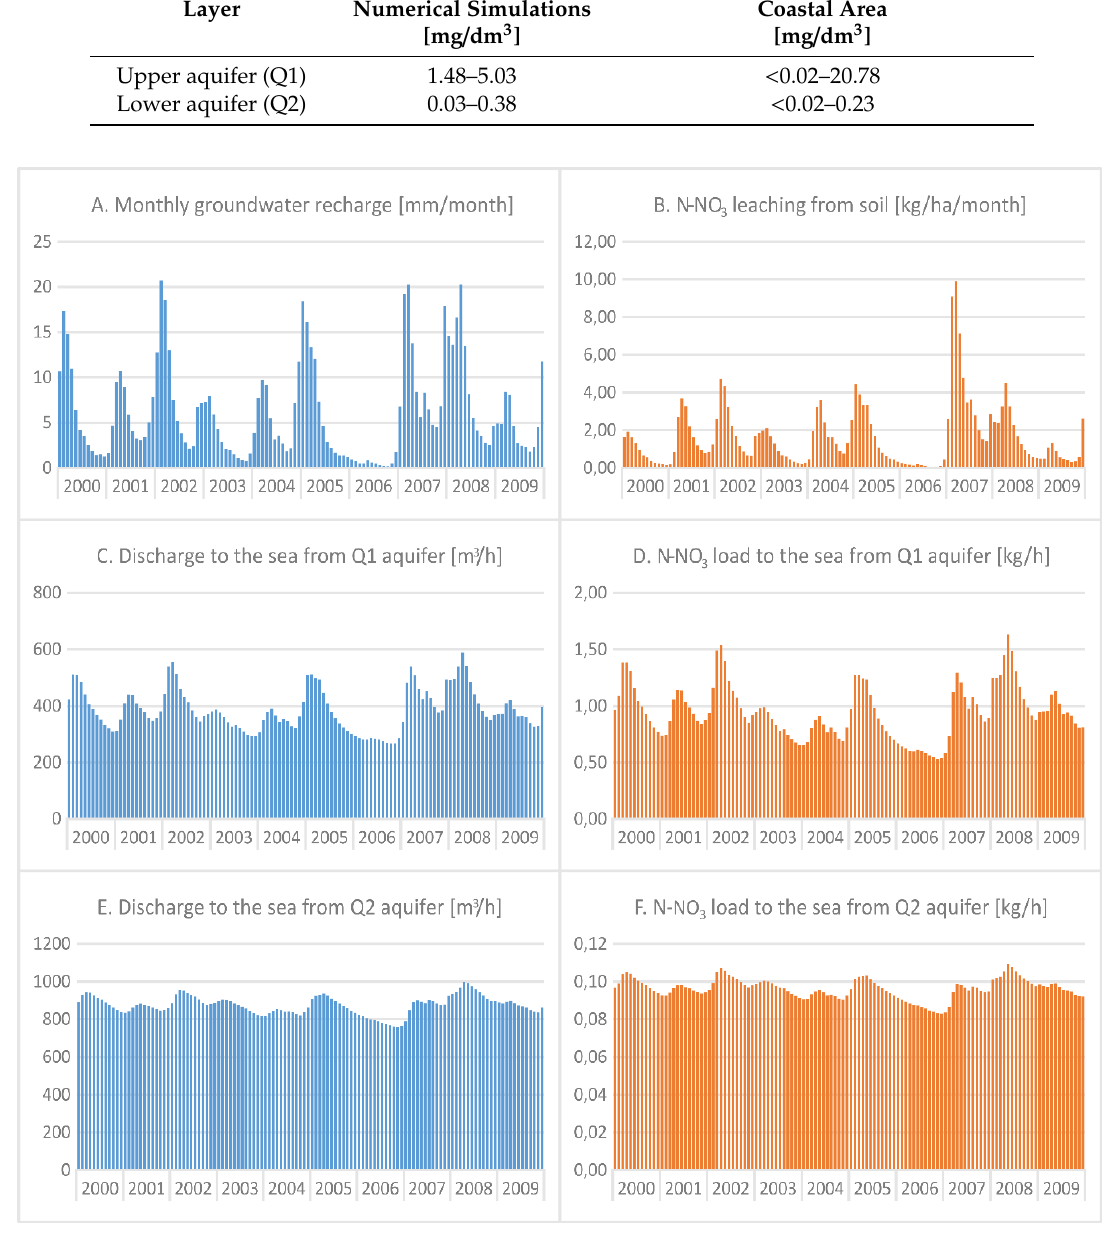
Figure 4. Average monthly values of selected groundwater budget components and N-NO 3 loads for scenario S1